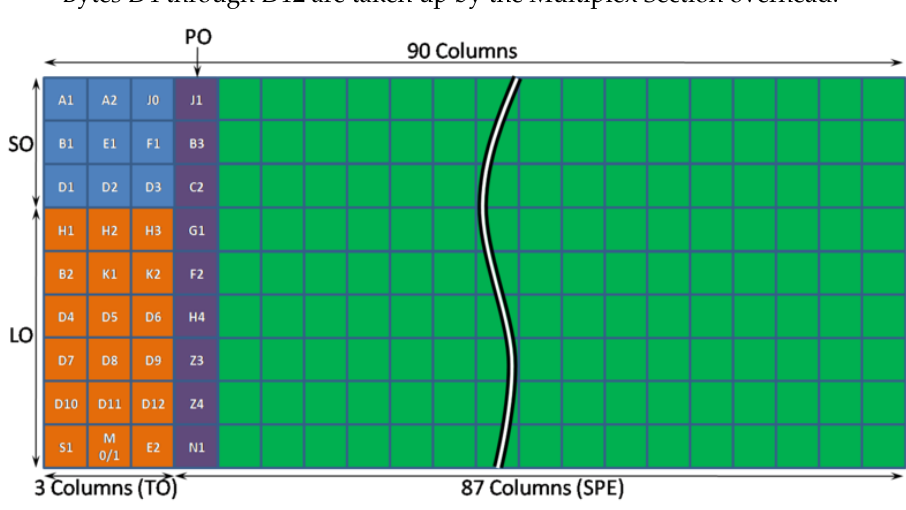
Figure 3. SDH frame structure